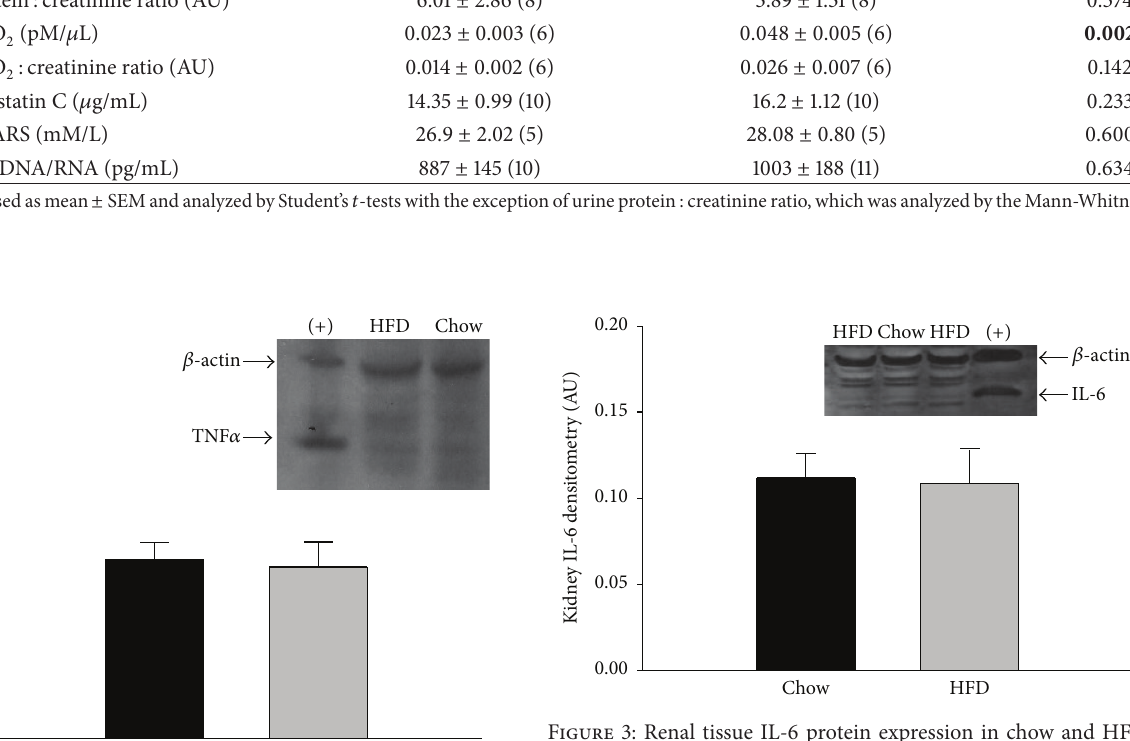
Figure 3: Renal tissue IL-6 protein expression in chow and HFD rats. There was no difference in the IL-6 expression of the two diet groups ( 𝑛 = 5 chow and 6 HFD rats). Retroperitoneal adipose tissue from a HFD rat was used as a positive control (+) and is shown in the last column. Data were analyzed by Student’s 𝑡 -tests and are expressed as means ± SEM. 𝑝 = 0.903